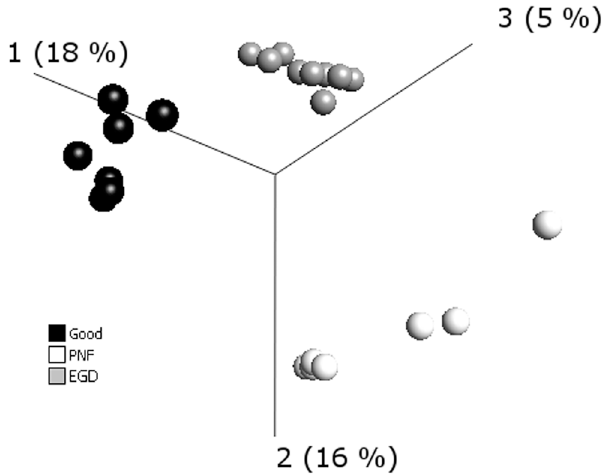
Fig 1. Principal Component Analysis (unsupervised hierarchial cluster analysis) of microRNA (miRNA) array data. miRNA was extracted from archival formalin fixed post-perfusion tru-cut donor liver biopsies taken from donation after cardiac death (DCD) livers of varying clinical outcome. DCD groups were categorized as primary non function (PNF) retransplanted within a week (n = 7), good functional outcome (n = 7) peak aspartate transaminase (AST) (cid:1) 1000 IU/L and early graft dysfunction (EGD) (n = 9) peak AST (cid:3) 2500 IU/L. The principal component analysis shows clustering of samples according to DCD liver group of PNF, EGD and good (p = 0.05, q =